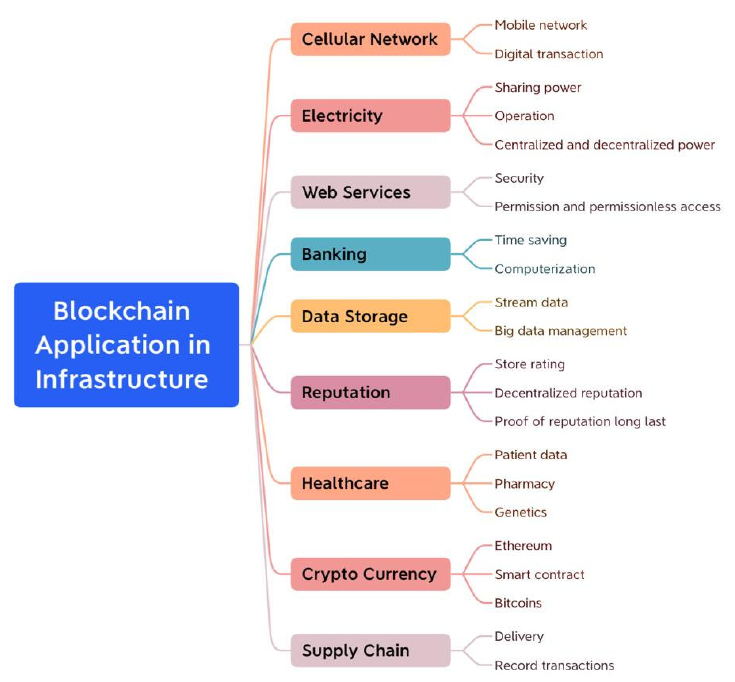
Figure 2. Applications of Blockchain in infrastructure.